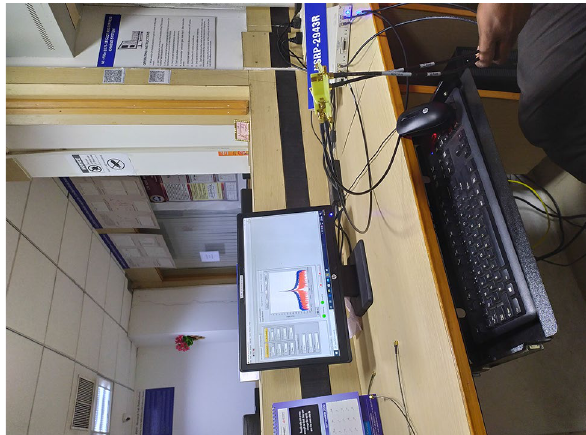
Figure 22. Real time implementation lab set-up.